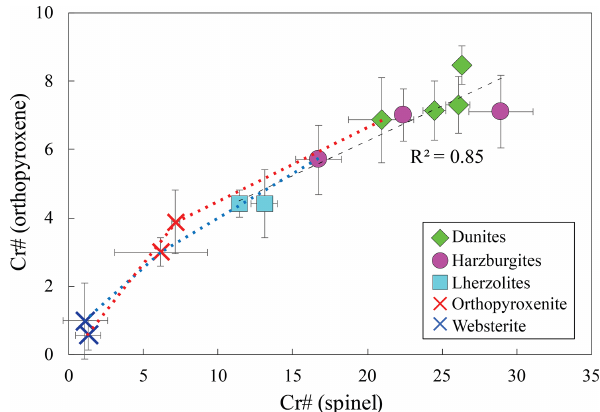
Figure 11. Plot of Cr# [100 × Cr /( Cr + Al ) , mol%] of orthopy- roxene versus Cr# of coexisting spinel (mol%) for the Rocca d’Argimonia peridotites. Data are averaged per sample; error bars represent the standard deviation of the mean value (2 σ ). The dia- gram also reports the compositions of orthopyroxene–spinel pairs from the contact zone at the boundaries between the thin gab- bronorite BI2/5 and BI10/3 dykes and host peridotites. The dotted tie lines refer to these contact zones and physically adjacent peri- dotites (blue: sample BI2/5; red: sample BI10/3).